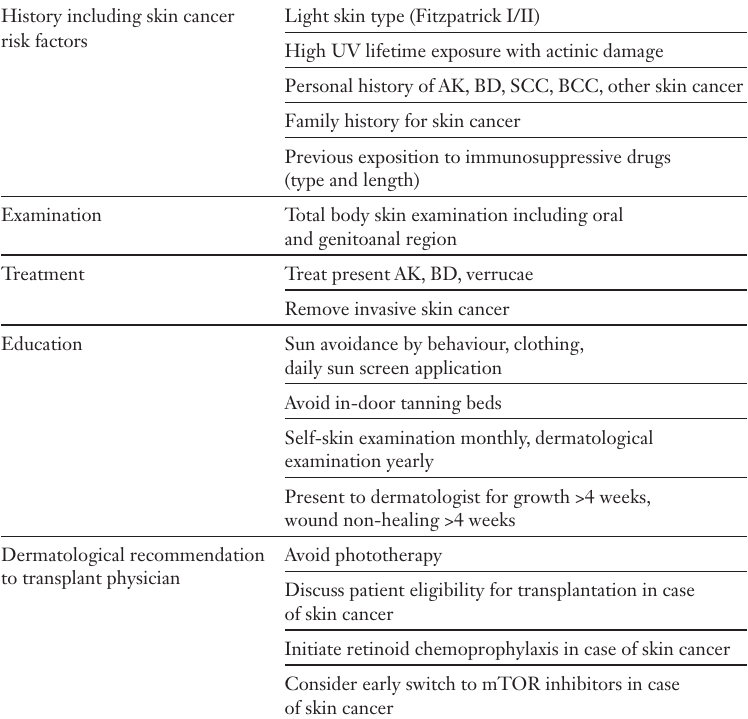
Pre-transplantation screening